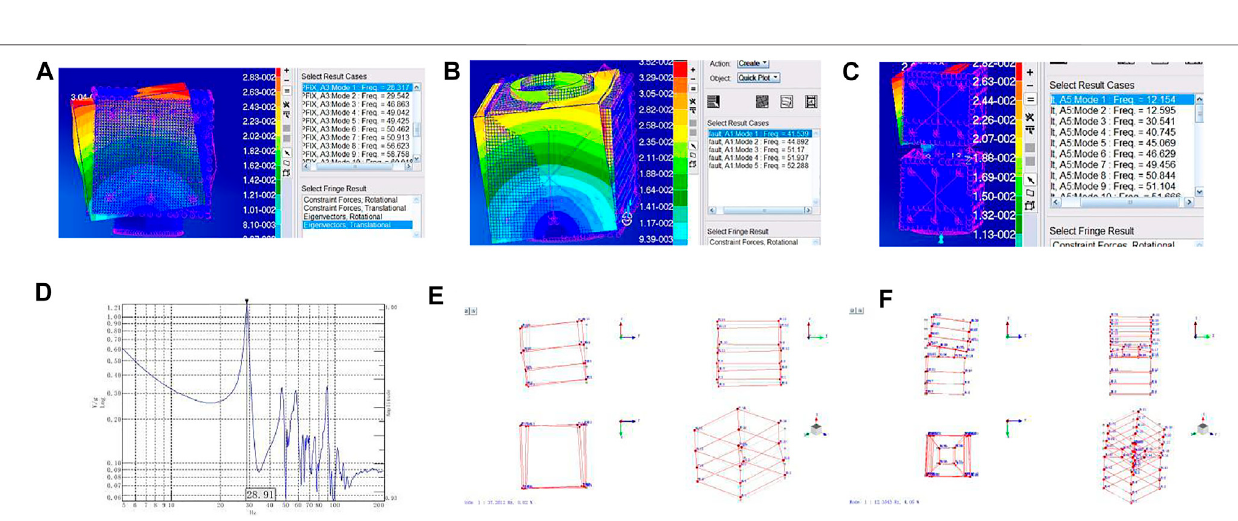
Frontiers in Mechanical Engineering |